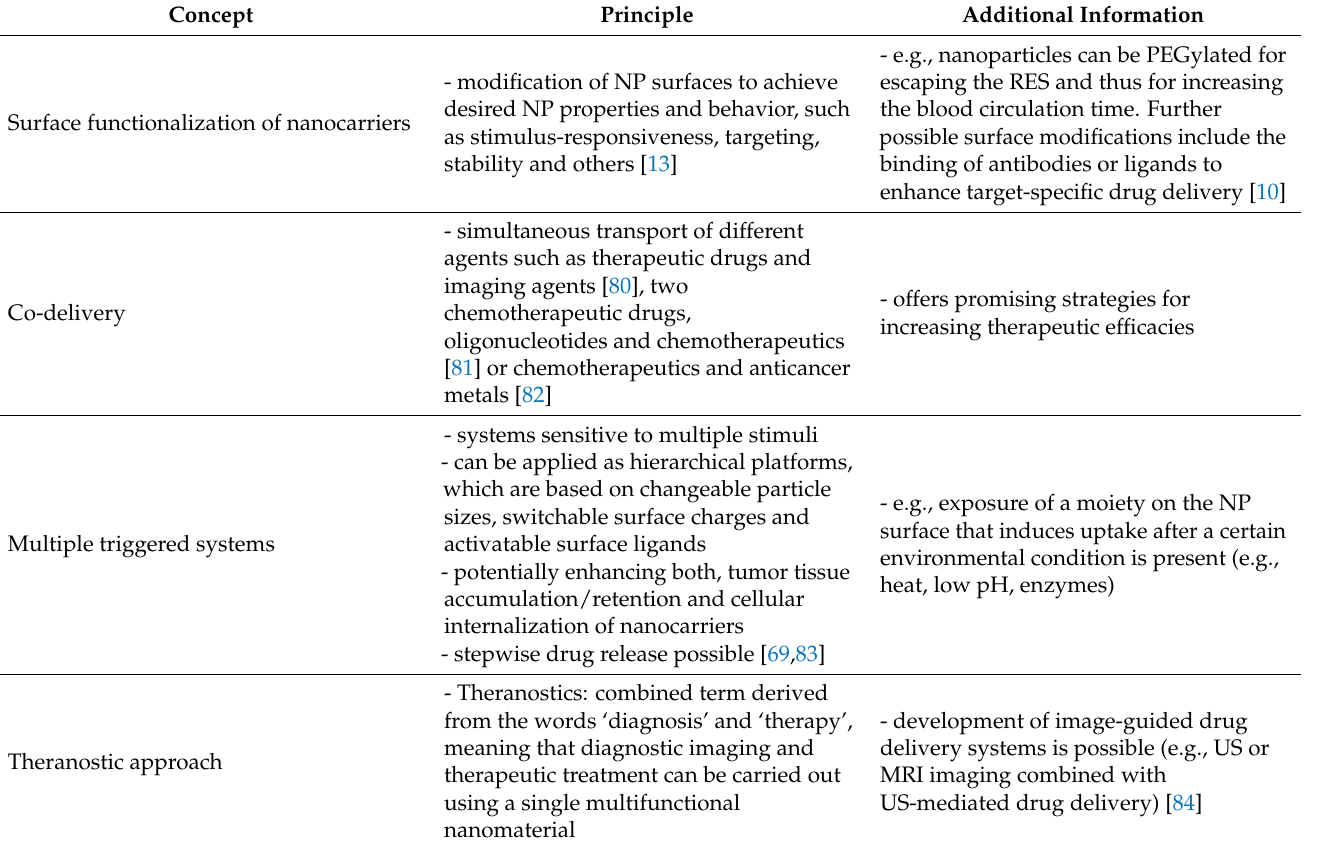
Table 2. Concepts not only restricted to US-triggered drug